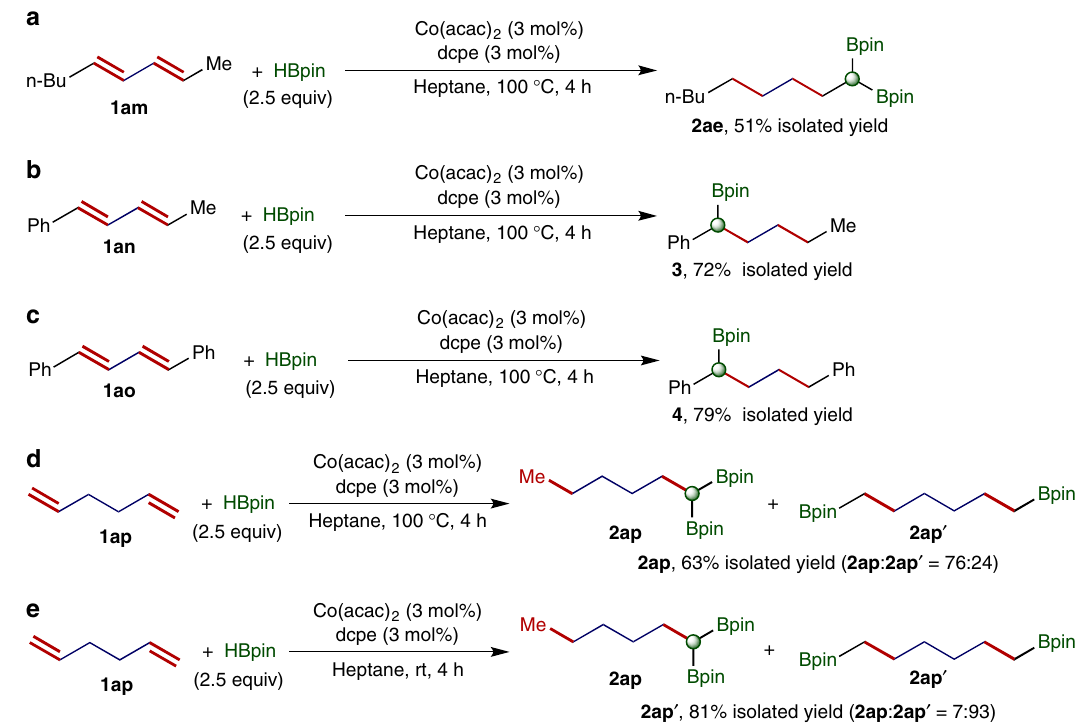
Fig. 4 Hydroboration of dienes containing two internal double bonds or two terminal double bonds. a Double hydroboration of diene 1am . b Sequential hydroboration/hydrogenation of diene 1an . c Sequential hydroboration/hydrogenation of diene 1ao . d Double hydroboration of diene 1ap at 100 °C. e Hydroboration of diene 1ap at room temperature.